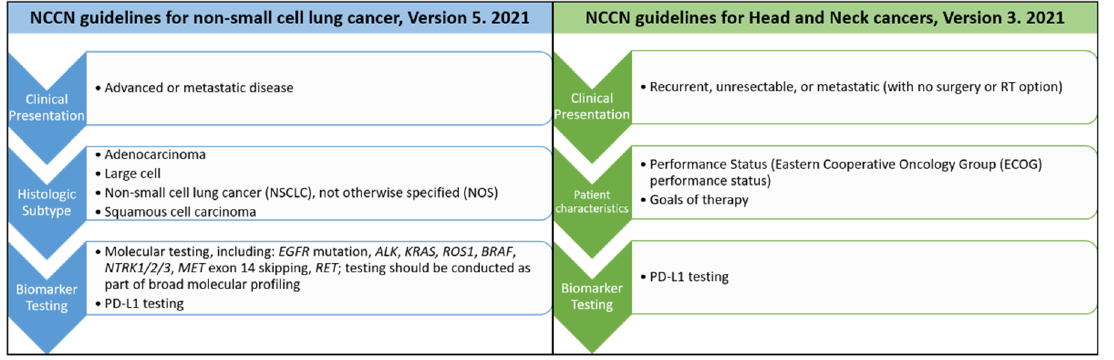
Figure 3. Comparison of the most recent treatment guidelines from The National Comprehensive Cancer Network ® (NCCN ® ) for non-small cell lung cancers and head and neck